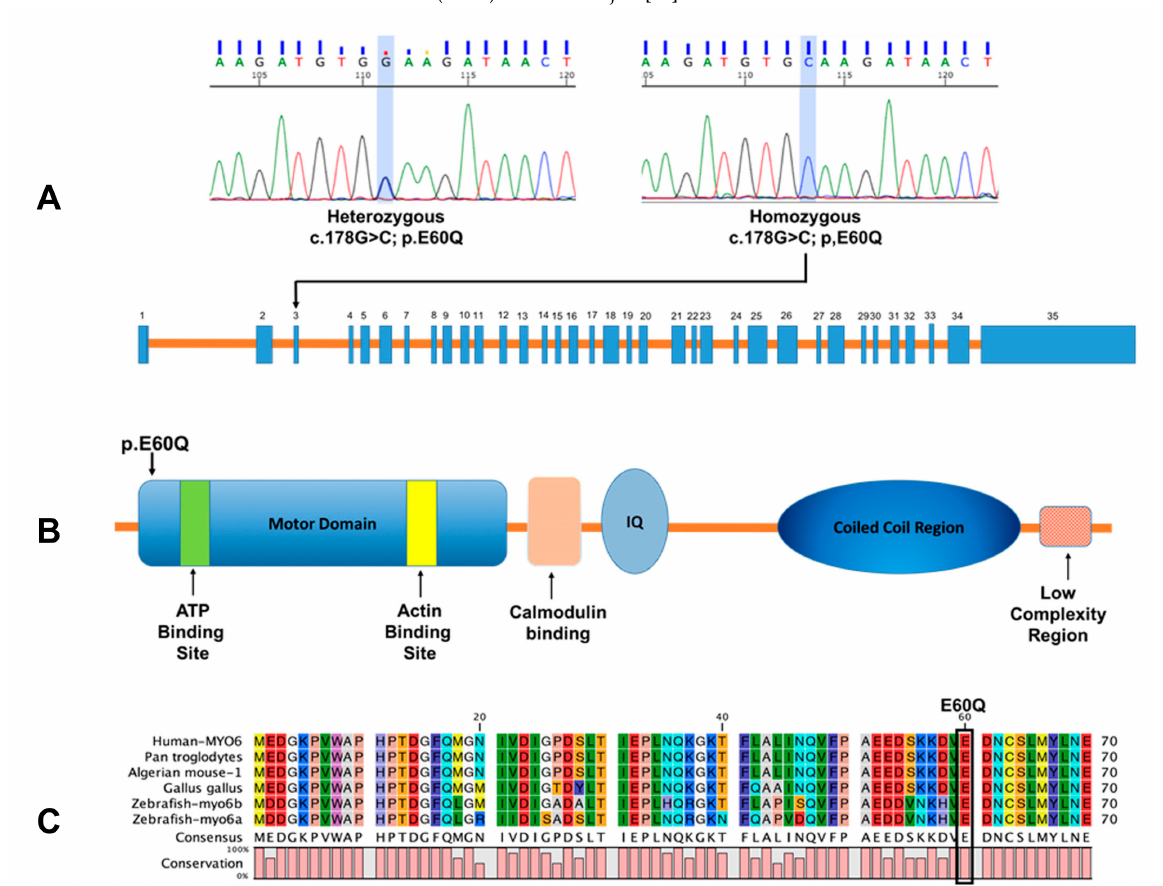
Figure 1. Mutation analysis of c.178G>C MYO6 variant. ( A ) Sanger sequence of heterozygous and homozygous missense c.178G>C variant in exon 3 of MYO6. ( B ) Schematic diagram of myosin VI protein. ( C ) MYO6 ontology across multiple species highlighting the conserved E60